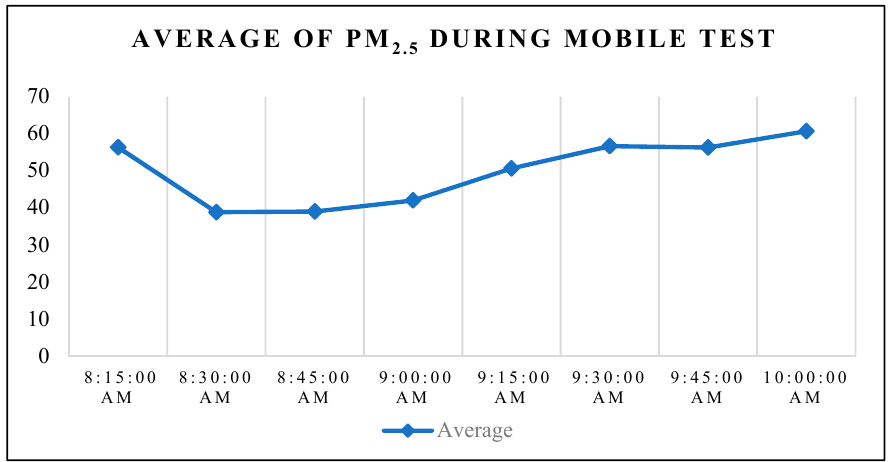
Figure 12. Hourly average of PM 2.5 during the mobile test run.